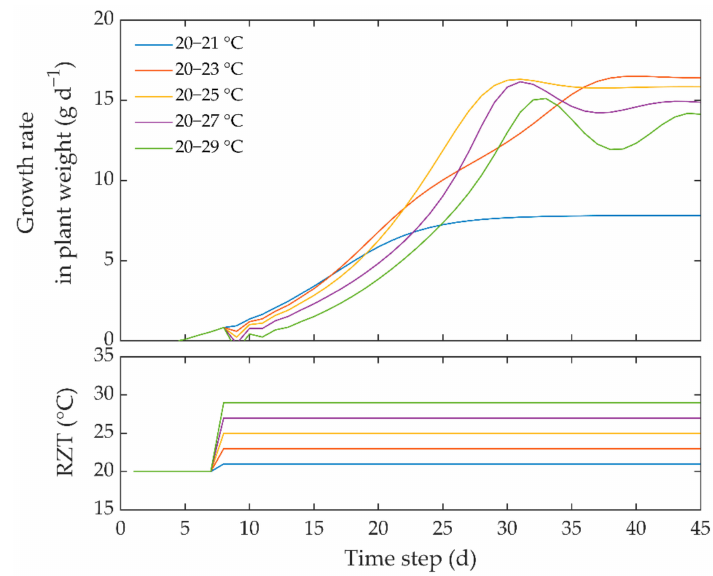
Figure 8. Estimated step response of the growth rate of plant weight to stepped RZT input, obtained via simulation.